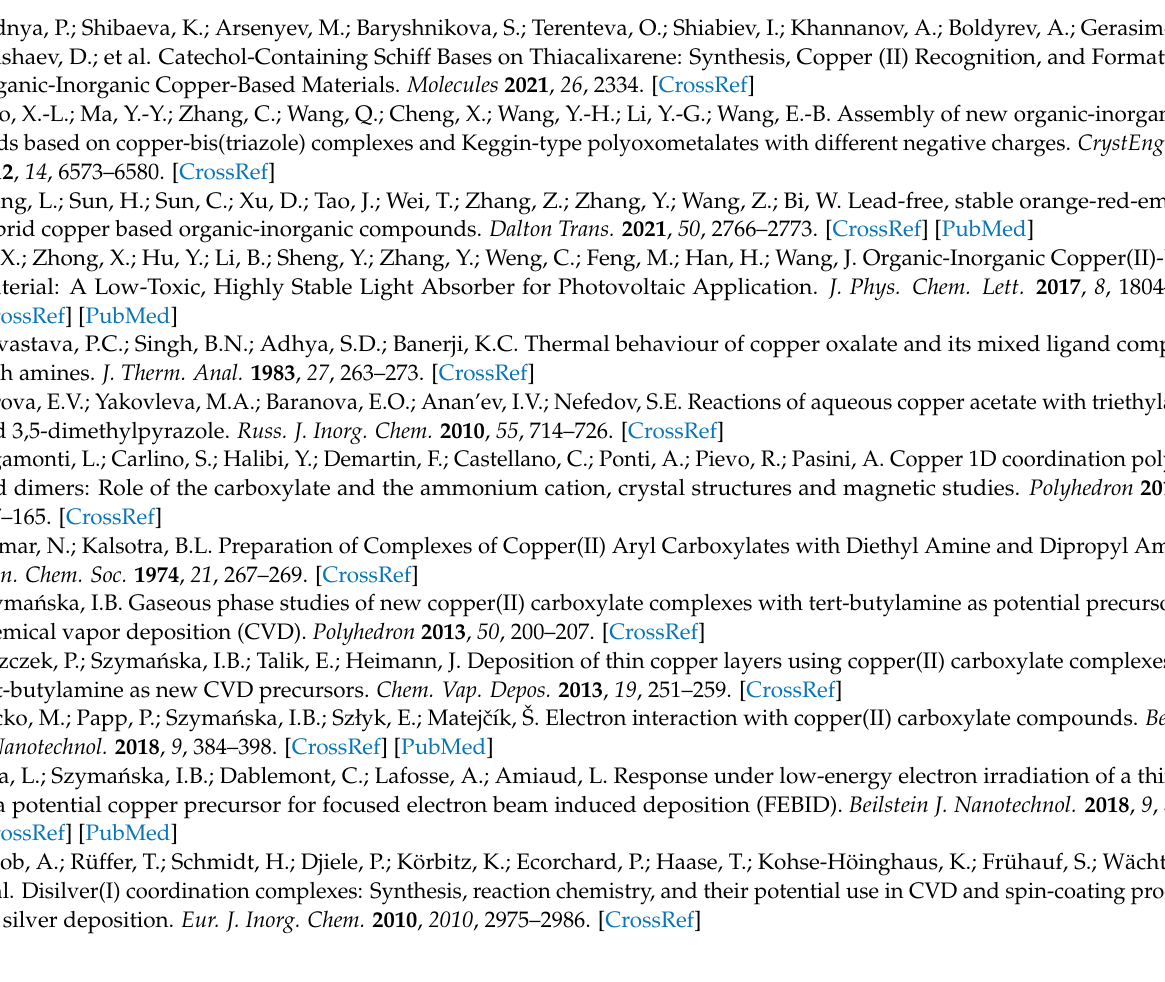
able infrared spectra VT IR for the vapor formed during the [Cu 2 ( i PrNH 2 ) 2 ( µ -O 2 CCF 3 ) 4 ] complex (7) heating; Figure S36 Temperature variable infrared spectra VT IR of vapors formed during the [Cu 2 ( i PrNH 2 ) 2 ( µ -O 2 CC 2 F 5 ) 4 ] complex (8) heating 433-733K and at temperature 493 K (red line); Figure S37 Optical microscope images of [Cu 2 (EtNH 2 ) 2 ( µ -O 2 CC 3 F 7 ) 4 ](3)/Si before heating, immer- sion time 30, before heating (A) the immersion line, (B) middle of the layer; Figure S38 SEM image of [Cu 2 (EtNH 2 ) 2 ( µ -O 2 CC 3 F 7 ) 4 ]( 3 )/Si immersion time 30, Mag = 200x, before heating; Figure S39 Optical microscope images of [Cu 2 (EtNH 2 ) 2 ( µ -O 2 CC 3 F 7 ) 4 ]( 3 )/Si, before heating, immersion time 20, coating count 10, Mag 5x, lower part of the substrate (A), middle of the layer (B), immersion line (C); Figure S40 Images from optical microscope after heating (A) [Cu 2 (EtNH 2 ) 2 ( µ -O 2 CC 3 F 7 ) 4 ]( 3 )/Si immersion time 20; (B) [Cu 2 (EtNH 2 ) 2 ( µ -O 2 CC 2 F 5 ) 4 ]( 2 )/Si immersion time